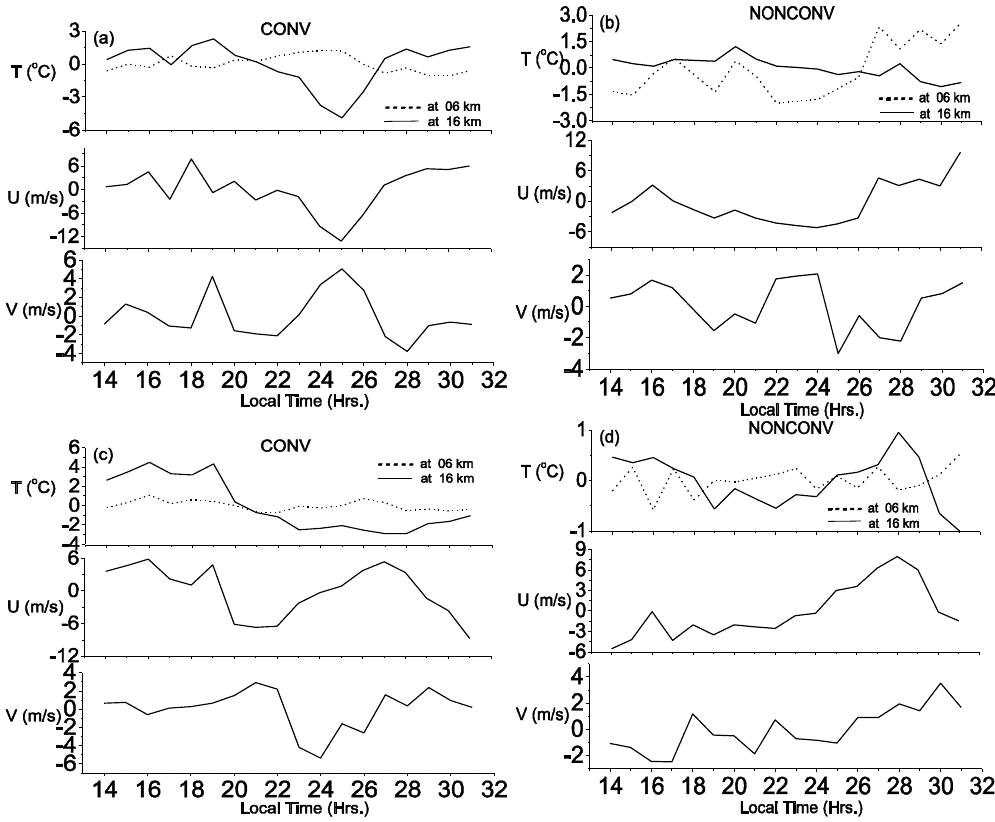
Fig. 5. Time series of the anomalies of temperature (upper panels), zonal wind (middle panels) and meridional wind (lower panels) are shown on (a) 30 November 2005, (b) 6 December 2005, (c) 9 December 2005, and (d) 18 December 2005. In the upper panels, dotted and solid line denotes variation in temperature at 6km and 16km height, respectively.